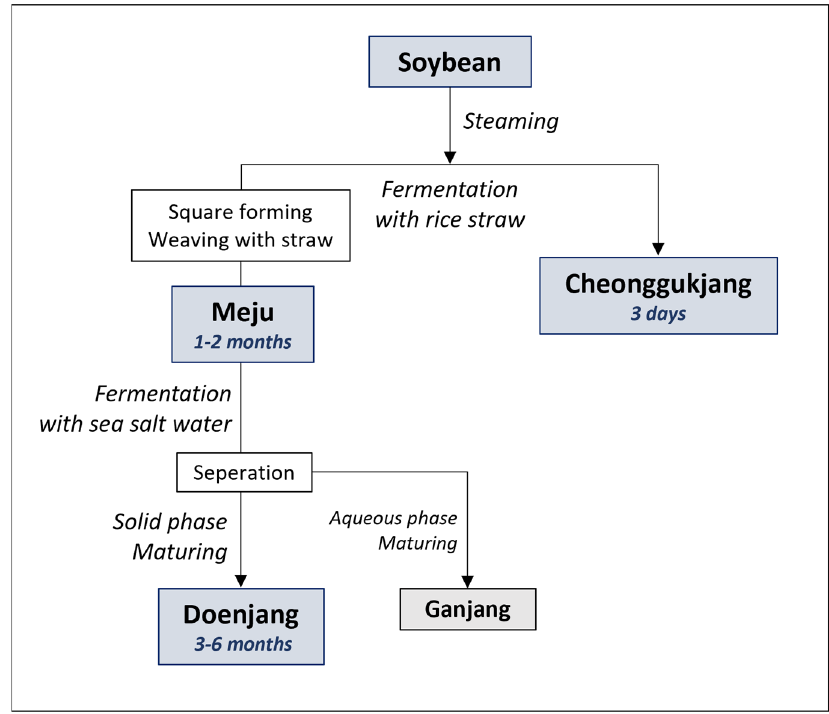
Figure 1. Manufacturing steps during the fermentative manufacturing of cheonggukjang, meju, and doenjang from raw soybean.